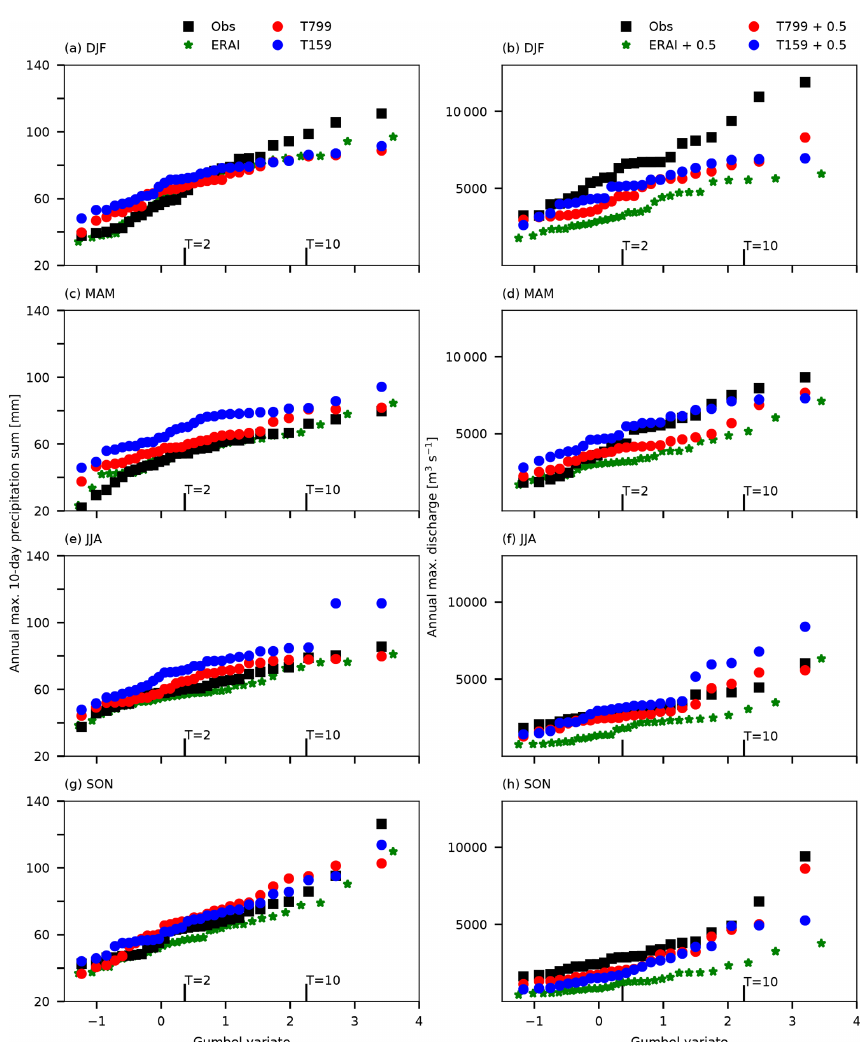
Figure 6. Gumbel plots of seasonal (DJF, MAM, JJA, and SON) maximum 10-day precipitation sums (mm) over the Rhine (a, c, e, g) and maximum discharge (m 3 s − 1 ) at Lobith (b, d, f, h) and their related return times T expressed in standardized Gumbel variate x = − ln ( − ln (T )) . Observed discharges are shown in black, high-resolution forcing (T799) in red, low-resolution forcing (T159) in blue, and forcing with ERA-Interim in green. The discharge results are output from the 0.5 ◦